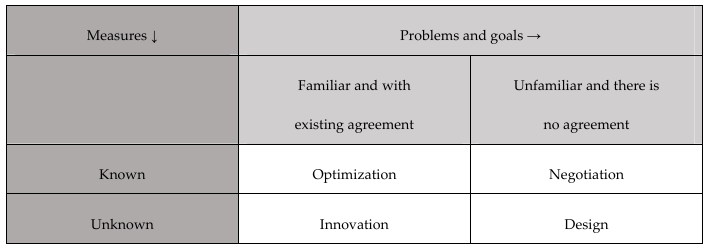
Figure 2. Definition of strategies characterized by the existing interpretation on the problem and goal definition and the agreement on measures [17].